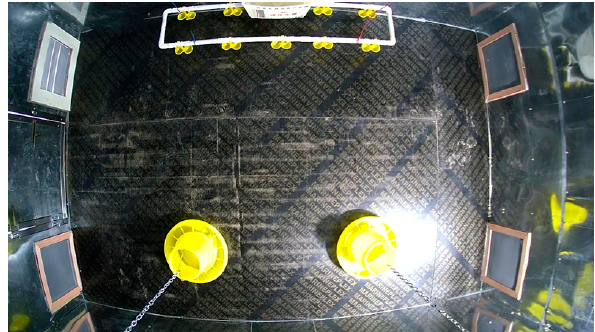
Figure 1. Internal picture of the experimental broiler chamber.